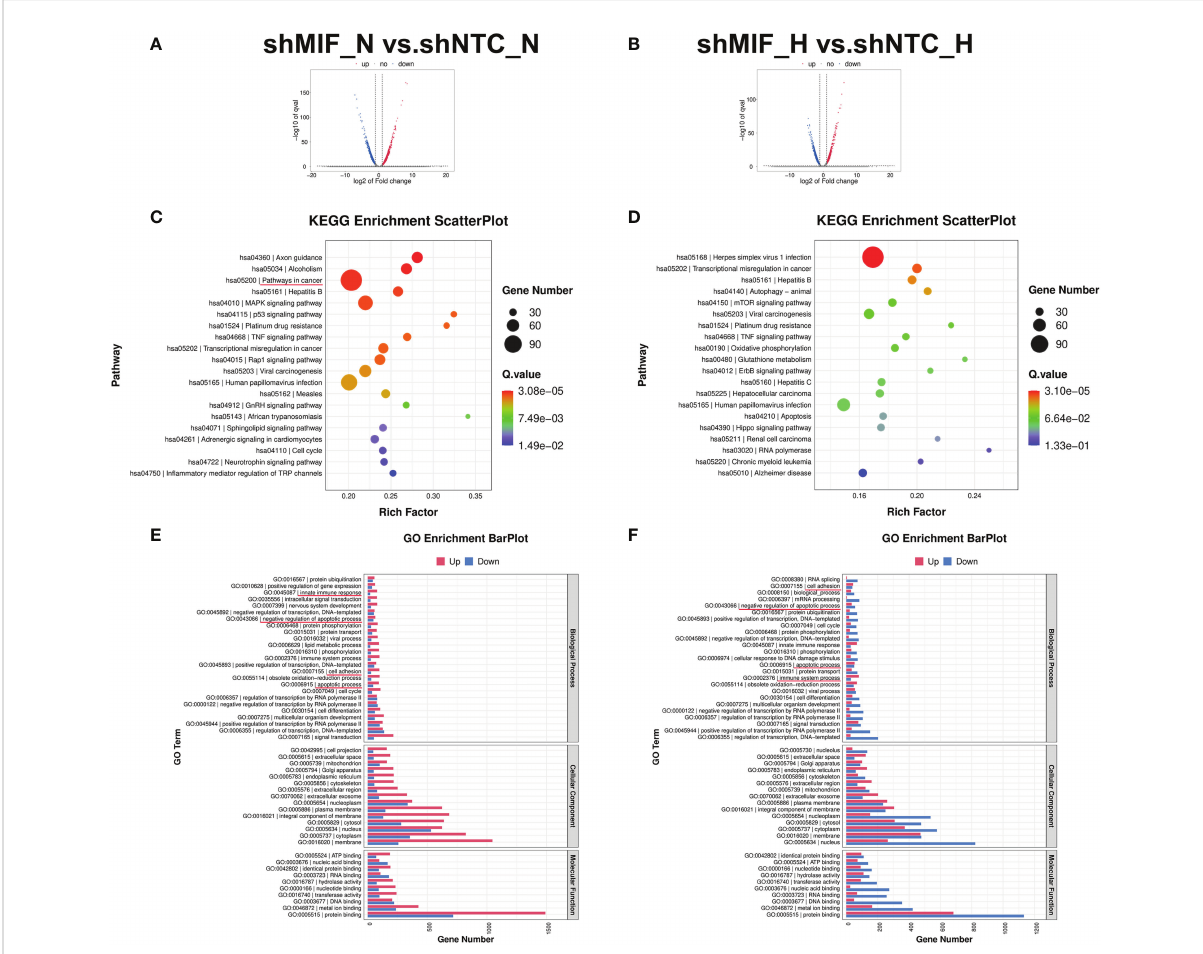
FIGURE 8 RNA-seq analysis in MIF knockdown PANC-1 cells (A, B) Volcano maps demonstrate the DEGs (fold-change >2 and FDR <0.005) regulated by MIF knockdown in PANC-1 cells. (C, D) KEGG pathway enrichment of the DEGs. (E, F) GO enrichment analysis of DEGs divided into three functional groups: biological process, cellular component, and molecular